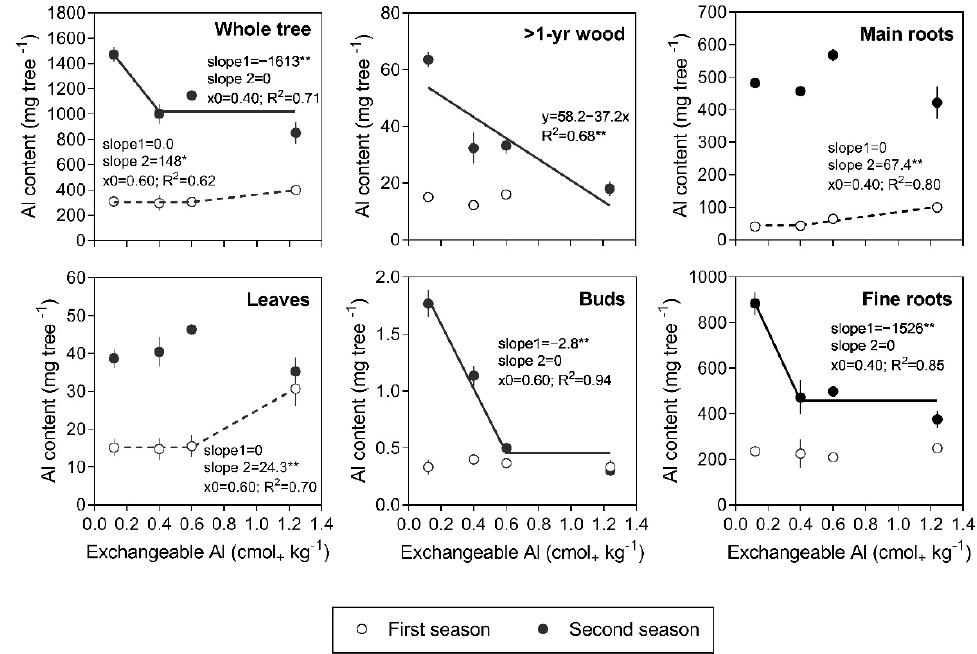
Figure 5. Relationship between Al content in the whole tree and in individual organs of sweet cherry trees and exchangeable Al in a volcanic soil. Values are the means, with standard errors as vertical bars ( n = 3). Significance of slopes: * p < 0.05; ** p < 0.01. In segmental regression, slope1 is the slope of the first line segment, slope2 is the slope of the second line segment, and X0 is the X value where the two line segments intersect.